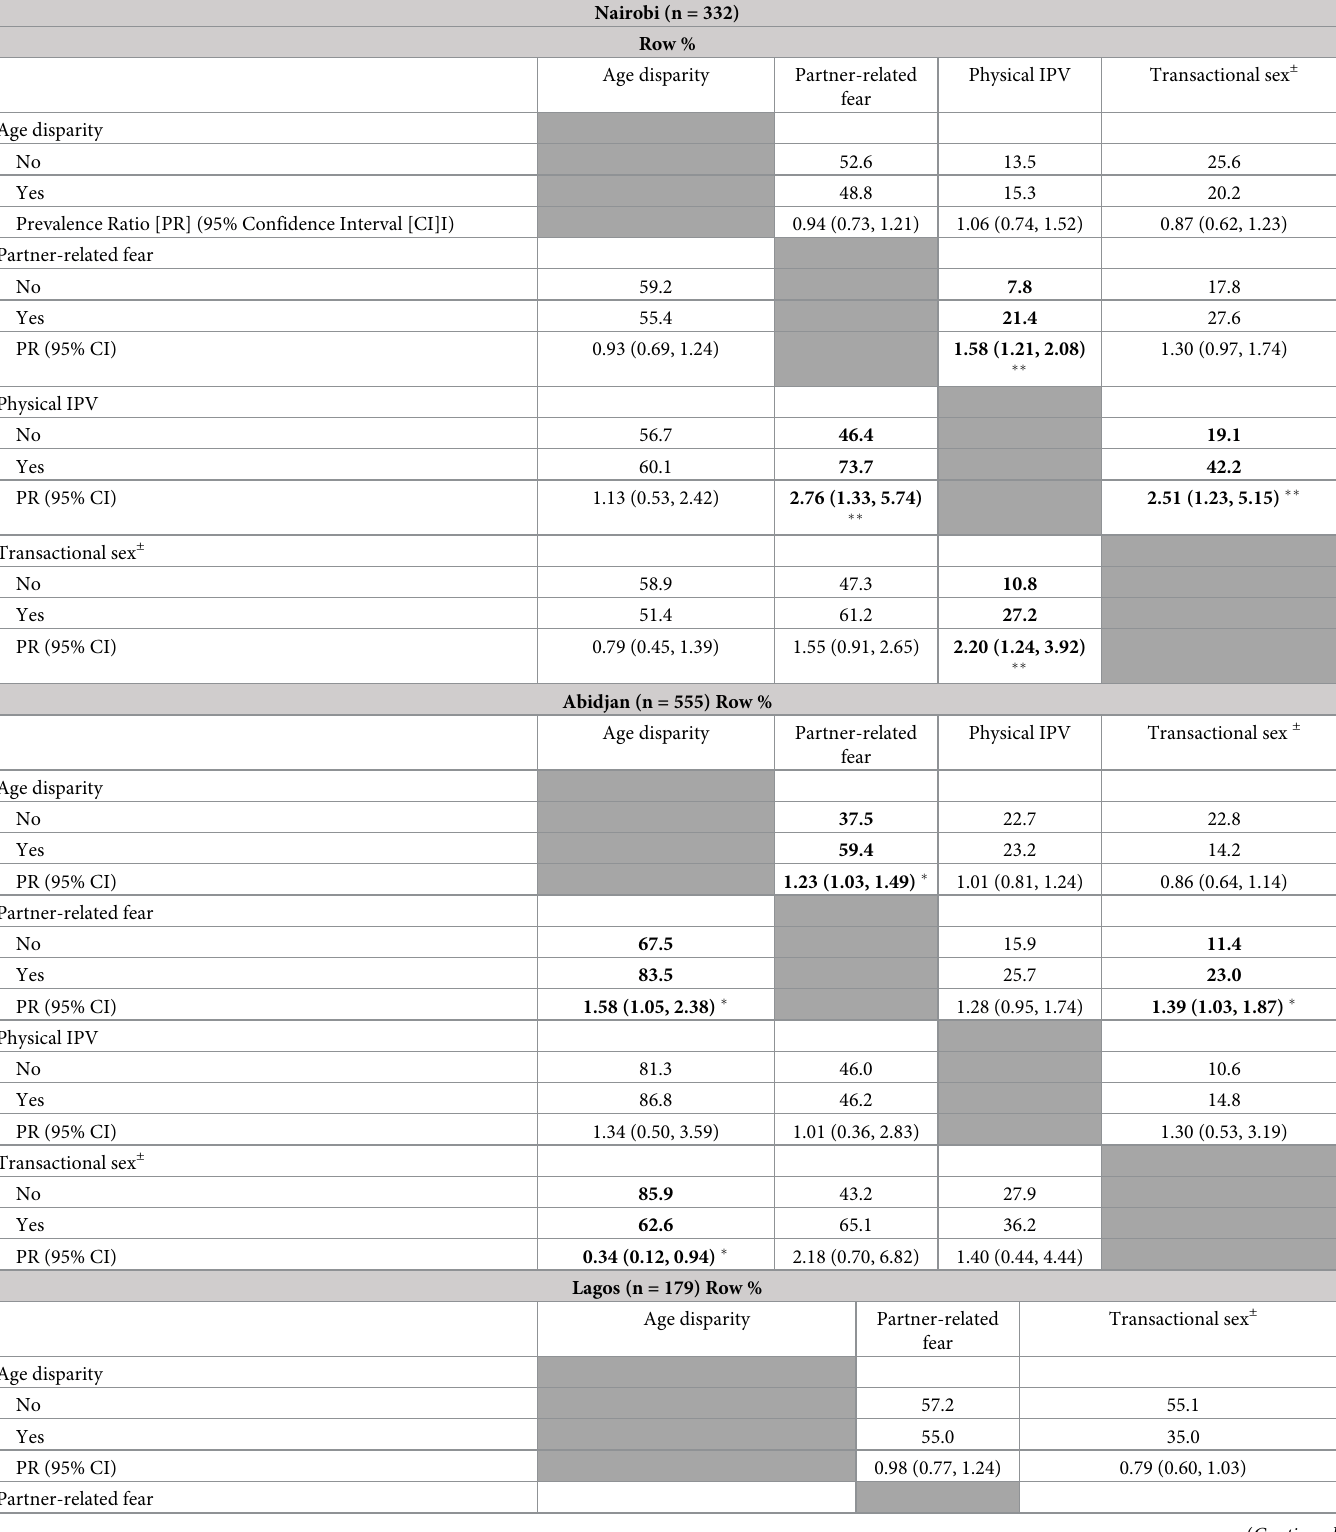
Table 2. Distribution and interplay of relationship power disparities among currently-partnered AGWY, by site,